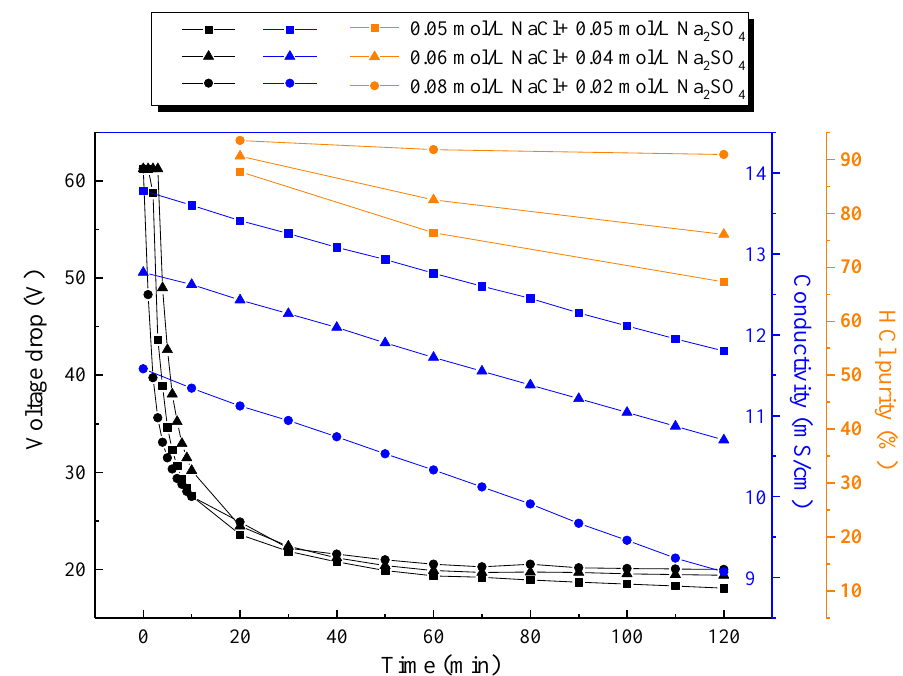
Figure 6. Effect of the monovalent and divalent components on the voltage drop across the SBMED stack, conductivity evolution curves in the salt compartment and HCl purity in the acid I compartment. Other experimental conditions: current density, 20 mA/cm 2 ; electrode rinse solution, 0.3 mol/L Na 2 SO 4 ; flow rate of each circulation, 200 mL/min.